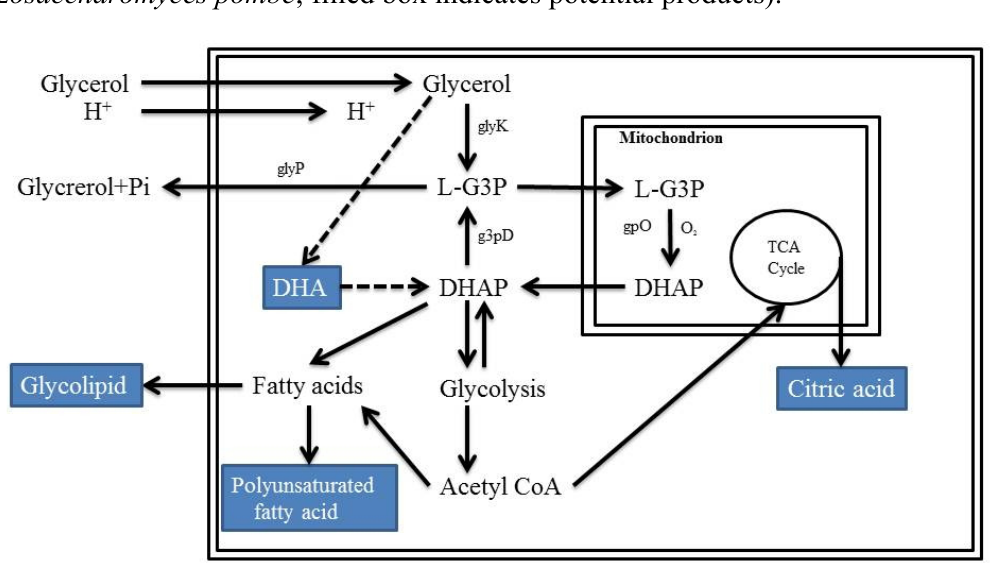
Figure 3. Eukaryotic pathway of glycerol utilization. Enzymes: glyK, glycerol kinase; glyP, glycerophosphatase; gpO, glycerophosphate oxidase; g3pD, glycerol-3-phosphate dehydrogenase. Chemical intermediates and products: DHA, dihydroxyacetone; DHAP, dihydroxyacetone phosphate; L-G3P, L-glycerophosphate. (Dash line indicates reactions in Schizosaccharomyces pombe ; filled box indicates potential